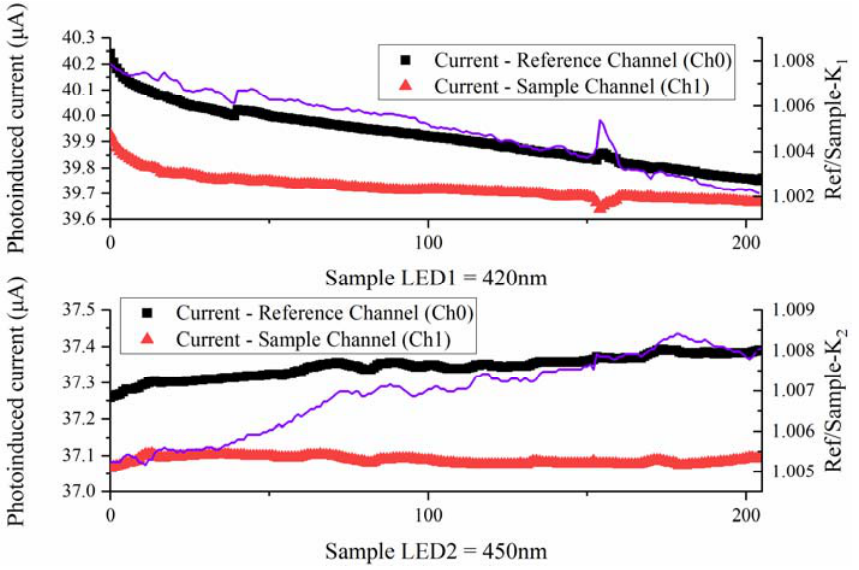
Figure 7. The correction coefficient readings at two wavelengths.